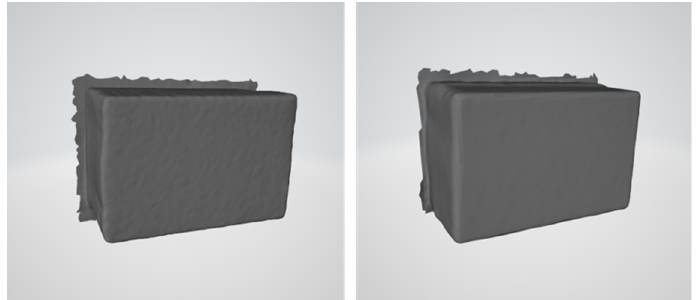
Figure 2. 3D virtual model of lithium disilicate reference model.